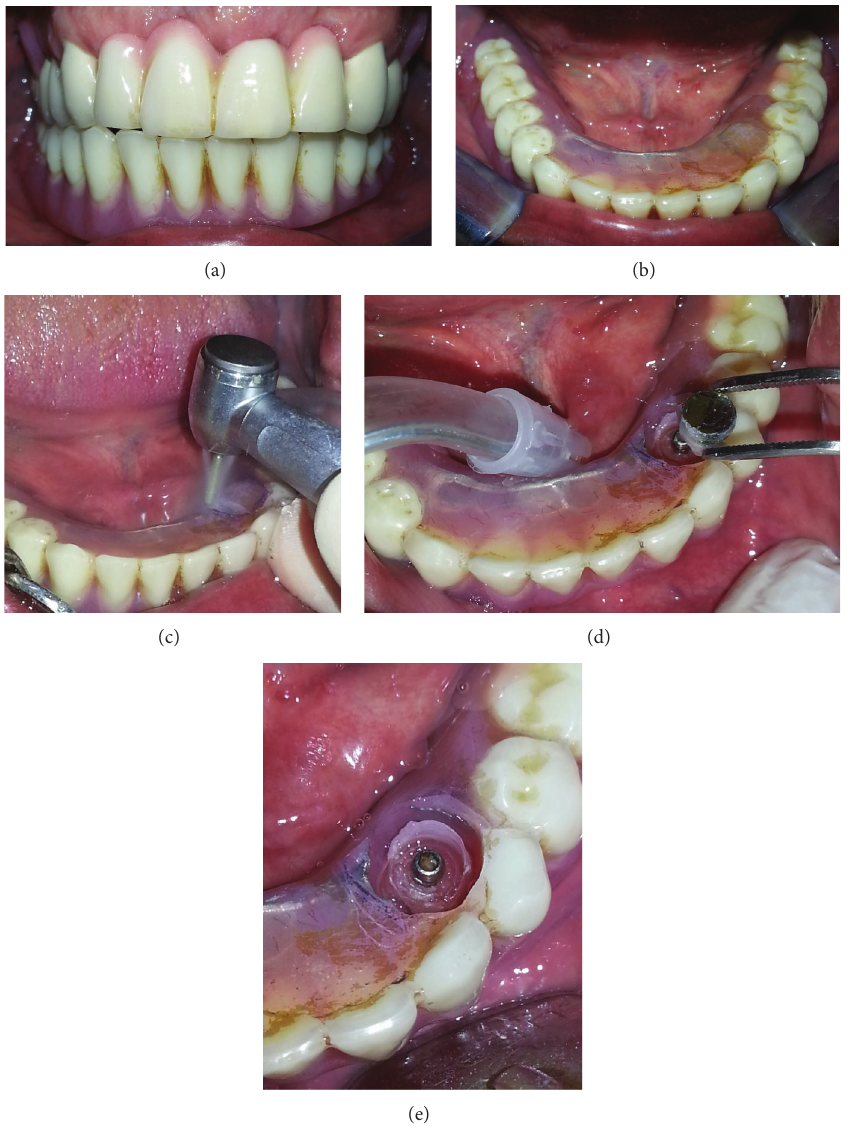
Figure 1: (a) Intraoral view of the prosthesis, (b) View of the mandibular implant supported denture, (c) marking the relevant portion of the denture, (d) removing matrix from the mouth, (e) implant supported denture with removed